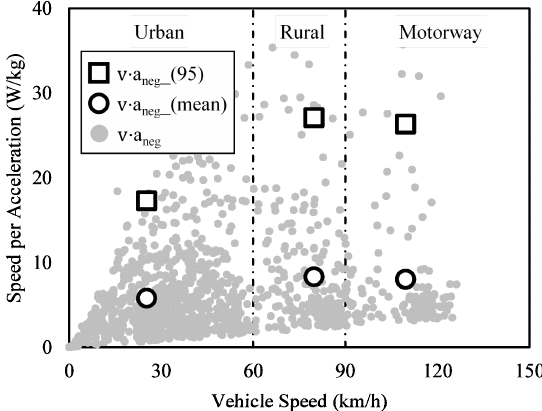
Figure 9. Verification of driving dynamics for